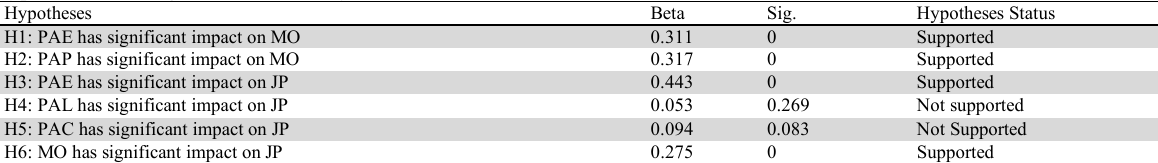
Hypotheses Testing Results Summary for Research Model Hypotheses